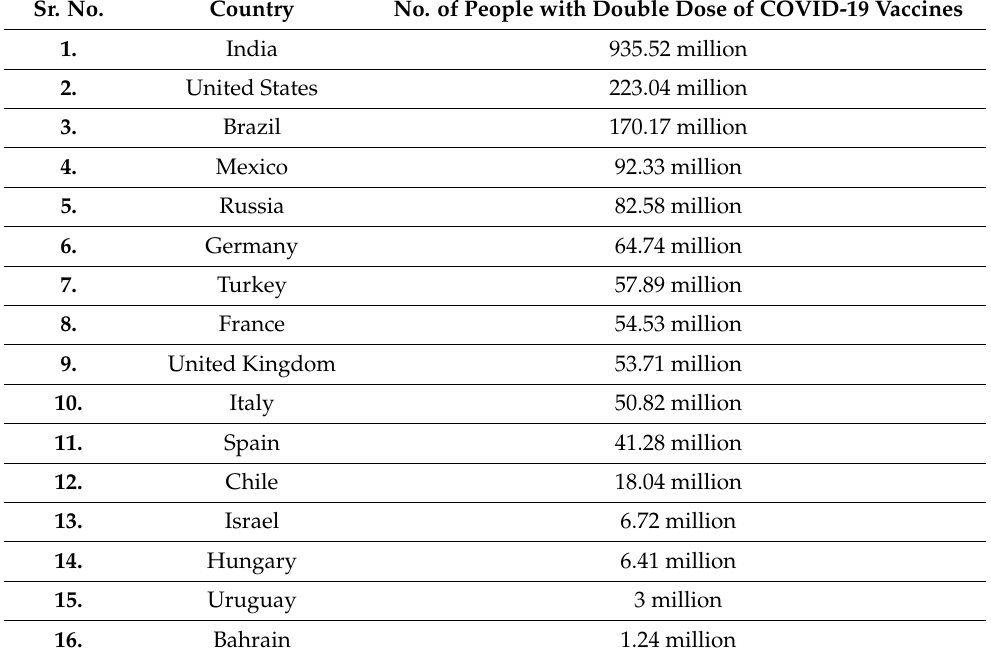
Table 2. Data on COVID-19 vaccines administered (by country) as of 7 August